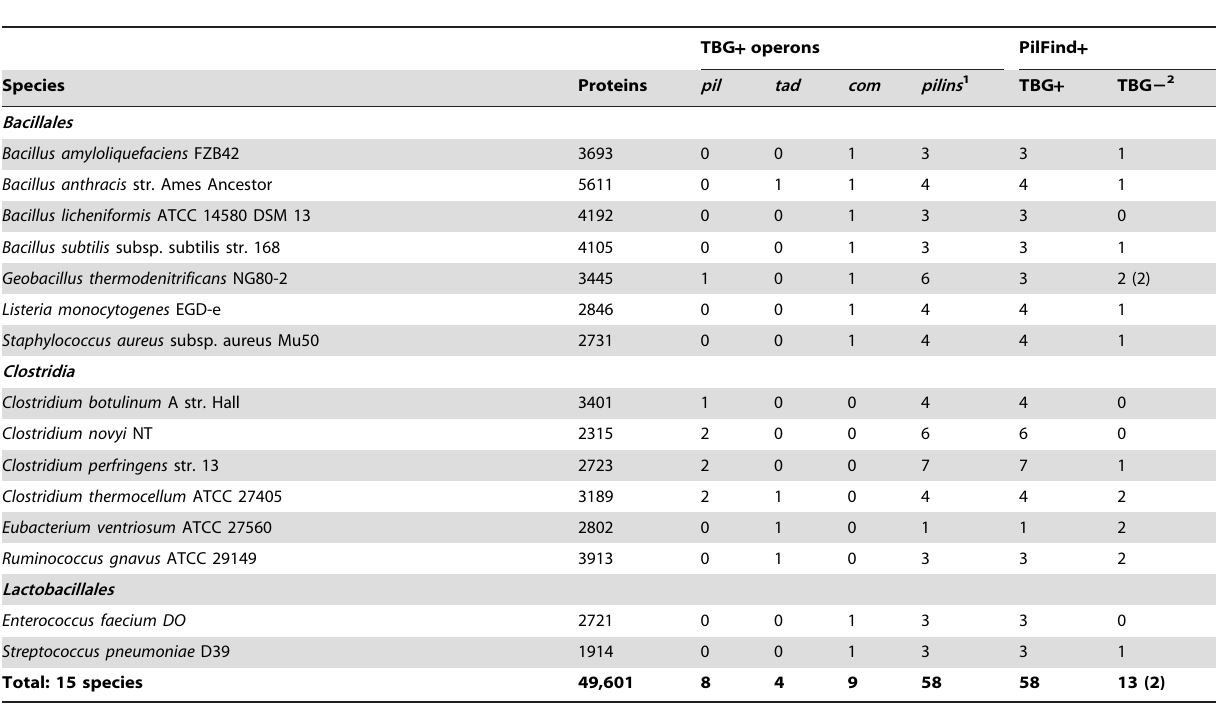
Table 2. Gram-positive type IV pilins used to construct a positive training set for